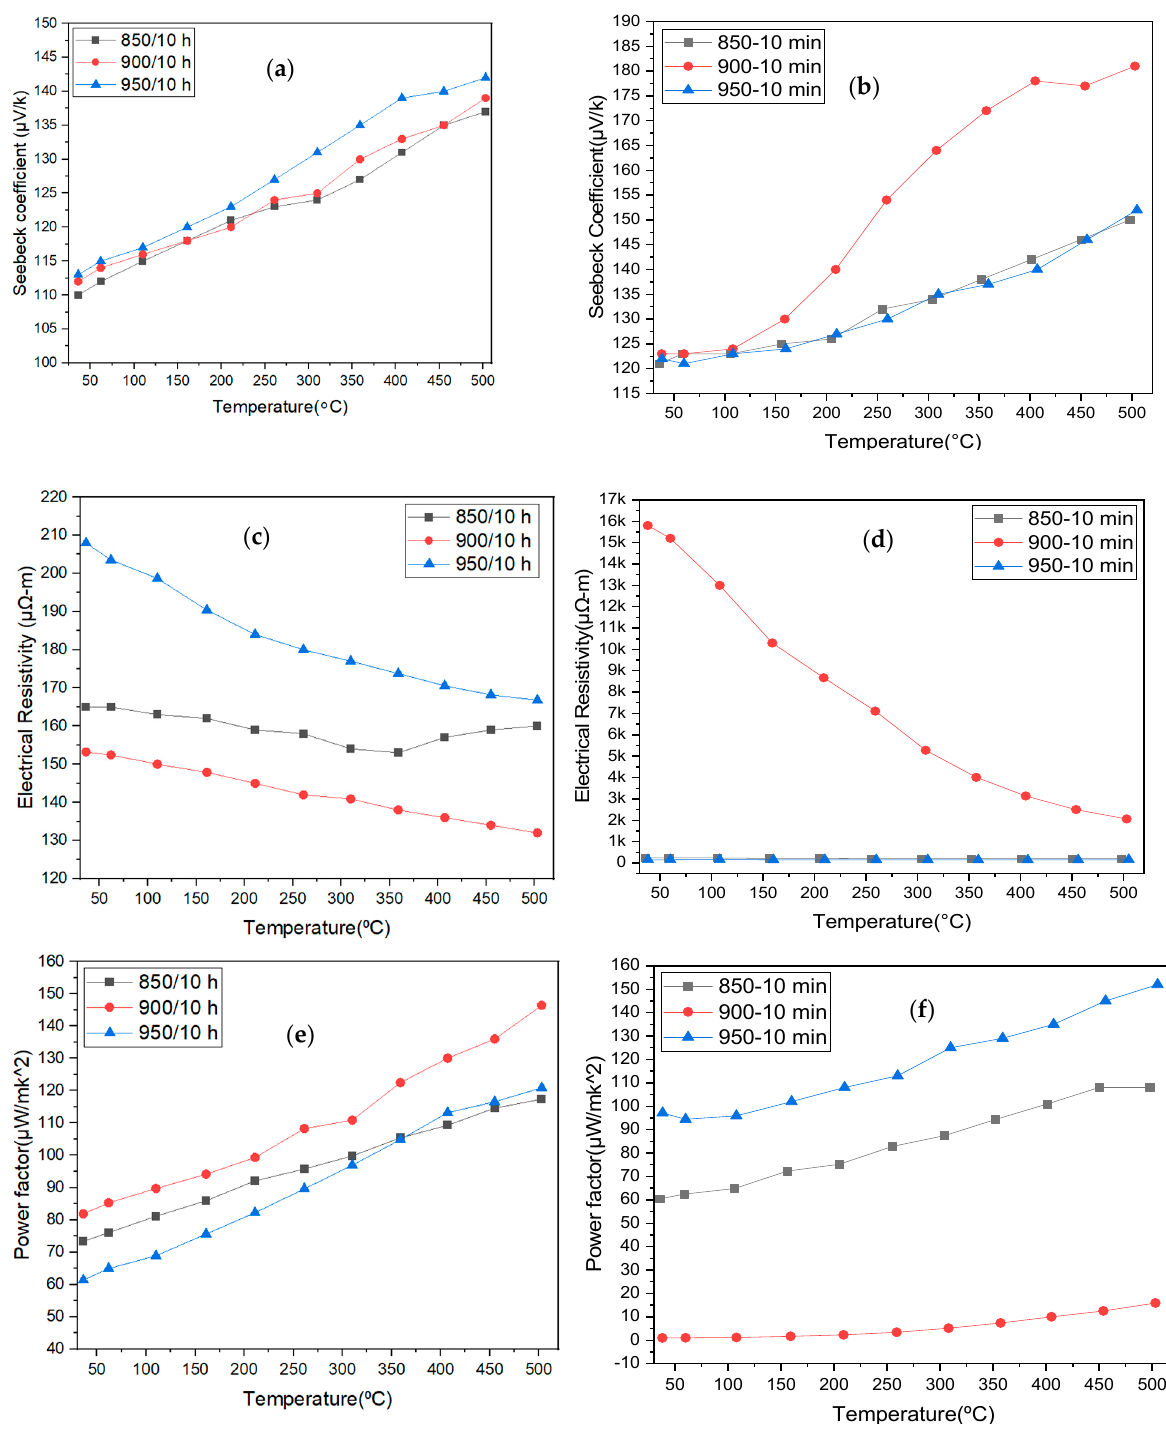
Figure 5. Electrical properties of sintered bulk samples ( a ), ( c ), and ( e ) are conventional sintered, and ( b ), ( d ), and ( f ) are SPS sintered samples.